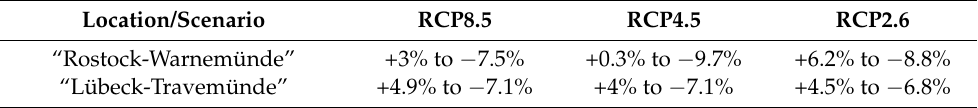
Table 4. Range of future changes of extreme wave heights near the selected locations and for different forcing scenarios and time periods of 40 years between 2006–2100 compared to the reference period